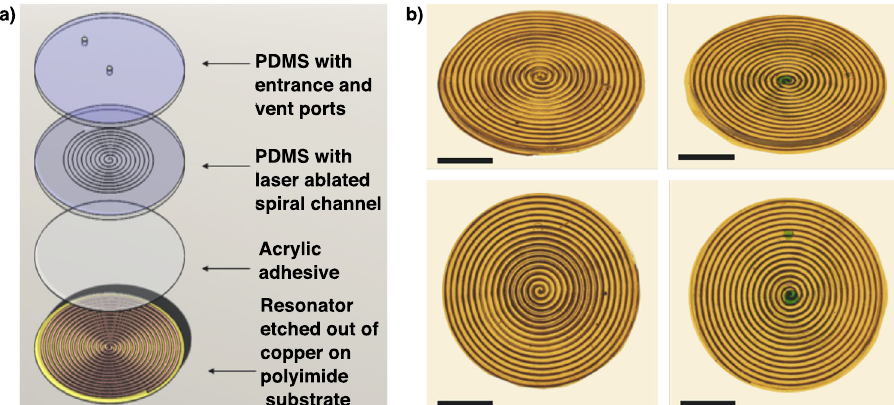
Fig. 1 Resonant sensor for sweat rate and composition. a Exploded view of resonant sweat sensor with layers labeled. b Photographs from angled and top view of sensor both empty (on the left) and fi lled with dyed DI water (on the right), scale bar = 10 mm.